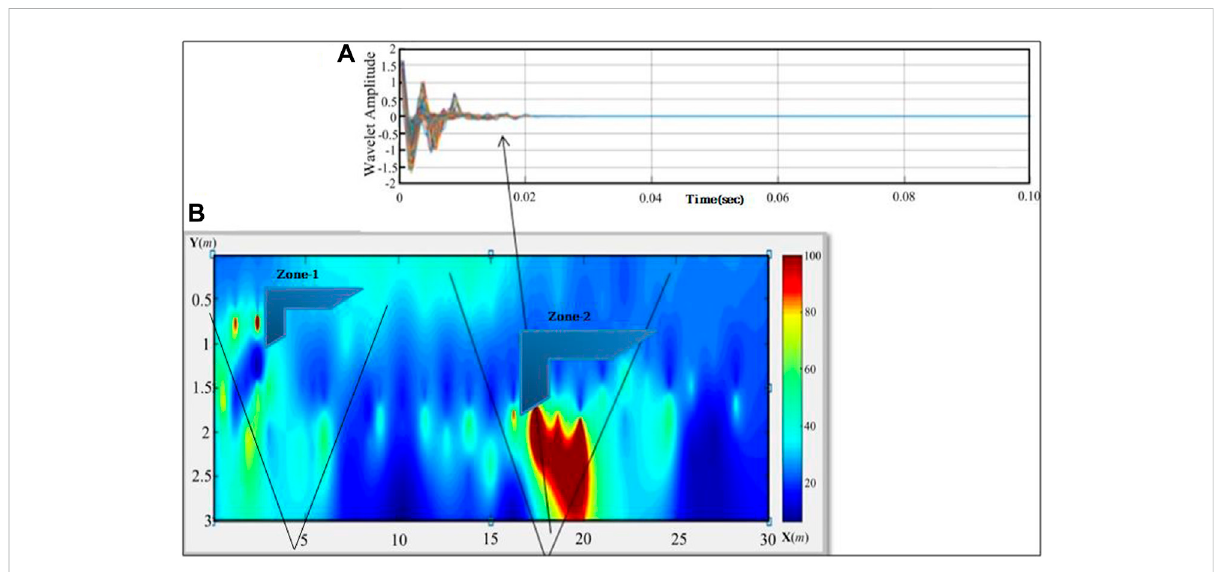
FIGURE 4 A2DcontinuouswavelettransformofGPRdata (A) motherwaveletapplicationforcontinuouswavelettransformmodulus (B) topographicGPR illustration of an archaeological test site with two marked zones named zone-1 and zone-2 which are the target area of this